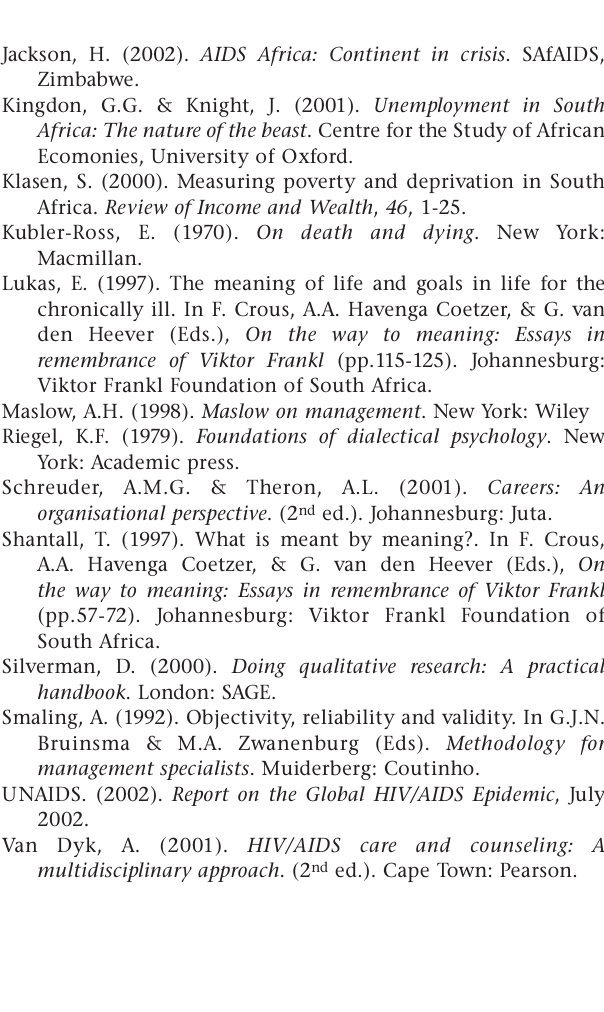
Figure 4: Relationship between response-phases of HIV and